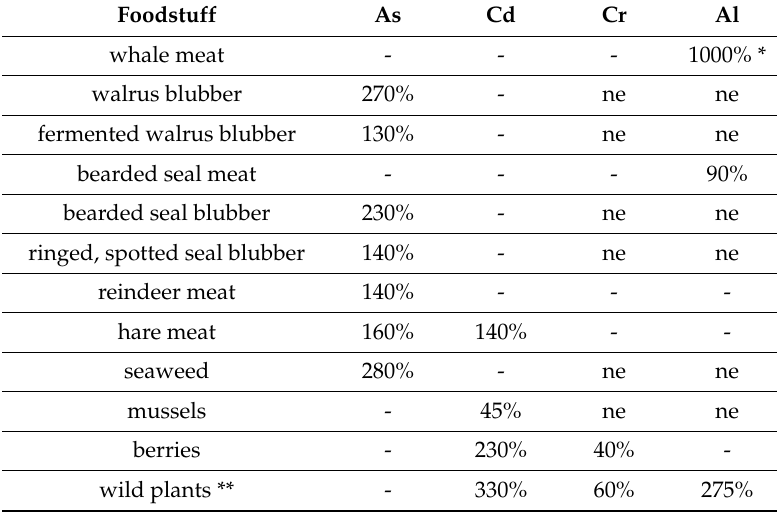
Table 5. Exceedances of the highest concentrations of metals in food samples over the Russian allowable levels (% of excess). Foodstuff As Cd Cr Al whale meat - - - 1000% * walrus blubber 270% - ne ne fermented walrus blubber 130% - ne ne bearded seal meat - - - 90% bearded seal blubber 230% - ne ne ringed, spotted seal blubber 140% - ne ne reindeer meat 140% - - - hare meat 160% 140% - - seaweed 280% - ne ne mussels - 45% ne ne berries - 230% 40% - wild plants ** - 330% 60%